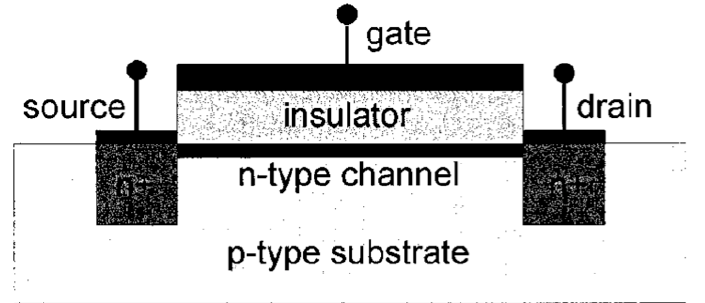
Figure 8. Schematic views of the metal/insulator/semiconductor fet (MISFET), also called MOSFET when the insulator is silicon oxide. Adapted from Horowitz [69]. Copyright © 1999, John Wiley and Sons.